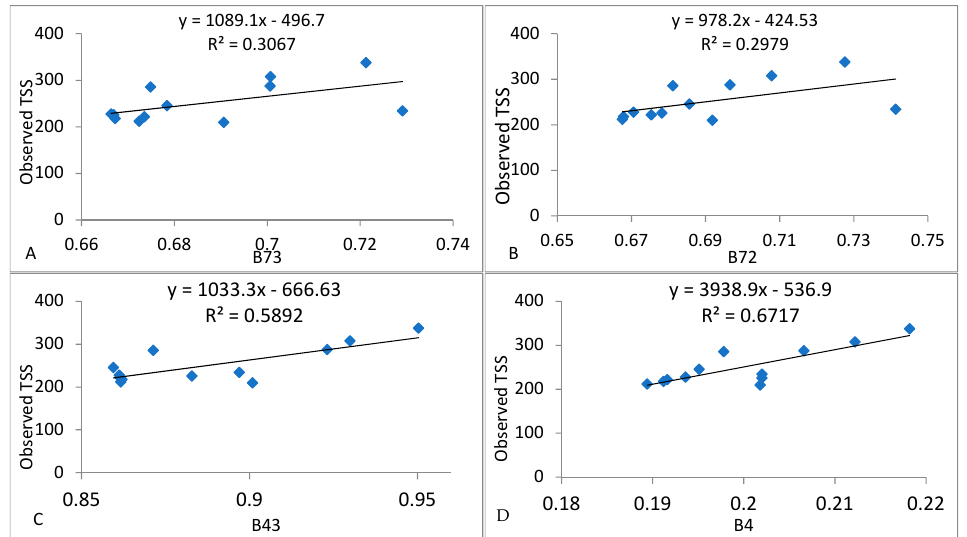
Figure 6. ( A – C ) Cross-relationships of in situ TSS and reflectance corresponding to the S2A band ratios to estimate TSS in the reviewed literature (Table 1). The highest correlation and the smallest error of S2A band (B4) with in situ TSS confirmed the appropriateness of using this band for esti- mating TSS in Koka reservoir water Figure 6 ( D ).